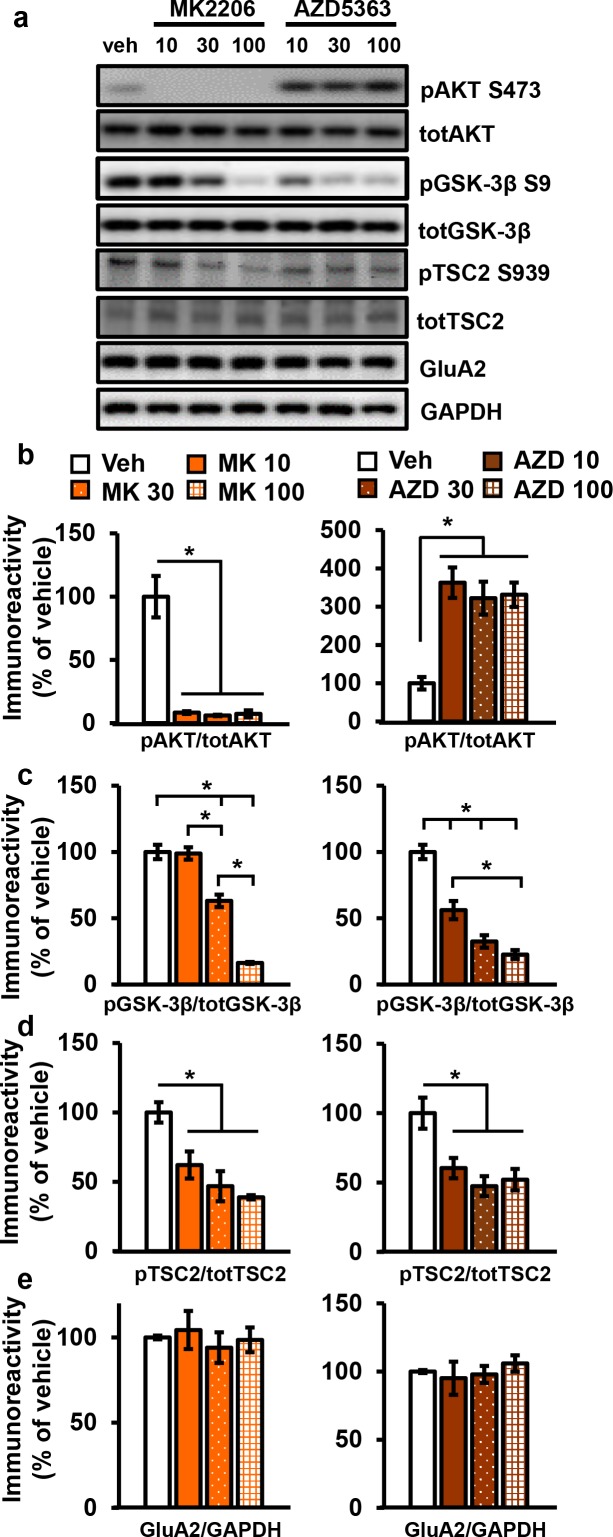
AKT inhibitors MK2206 and AZD5363 effectively inhibit AKT activity in hippocampal slices.(a) MK2206 and AZD5363 blocked AKT activity effectively, shown by reduced phosphorylation levels of the AKT substrate GSK-3β on serine 9 (pGSK-3β S9), but had different effects on phosphorylation levels of AKT itself on serine 473 (pAKT S473). (b) MK2206 (MK) significantly reduced pAKT S473 levels normalized to total AKT (totAKT) levels, while AZD5363 (AZD) significantly increased pAKT S473 levels (MK F(3.8) = 30.93, p<0.0001; AZD F(3.8) = 12.30, p=0.0023). (c) MK had a dose-dependent effect on pGSK-3β S9 levels normalized to total GSK-3β (totGSK-3β) levels, with no effect at 10 µM but significantly reduced levels at 30 and 100 µM compared with vehicle treatment (MK F(3,8)=74.56, p<0.001; post hoc comparisons: veh vs. MK10 p=0.998; veh vs. MK30 p=0.002; veh vs. MK100 p<0.001, MK10 vs. MK30 p=0.002, MK30 vs. MK100 p<0.001). AZD also had a dose-dependent effect on pGSK3β-S9 levels, with significant reduction at 10 µM in addition to the 30 and 100 µM doses compared with vehicle (AZD F(3,8)=39.69, p<0.001; post hoc comparisons: veh vs. AZD10 p=0.002; veh vs. AZD30 p<0.001; veh vs. AZD100 p<0.001; AZD10 vs. AZD100 p=0.01). (d) MK and AZD treatment significantly reduced phosphorylation of TSC2 at serine 939 (pTSC2 S939) (MK F(3,9)=10.27, p=0.0041; AZD F(3,9)=7.893, p=0.0089). (e) Levels of GluA2 normalized to GAPDH was not significantly altered after MK or AZD treatment (MK F(3, 8)=0.279, p=0.838; AZD F(3,9)=0.378, p=0.771). Veh = vehicle, MK10 = 10 µM, MK30 = 30 µM, MK100 = 100 µM; AZD10 = 10 µM, AZD30 = 30 µM, AZD100 = 100 µM, 3–4 mice/group, *p<0.05.